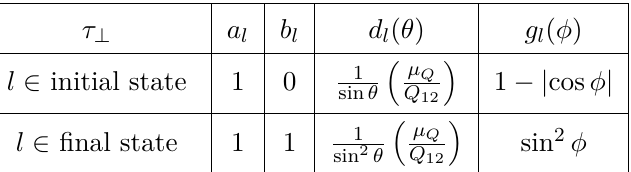
Table 1 . The C AESAR parametrisation valid for both plain and soft-drop groomed transverse thrust, given for initial- and final-state hard-process legs.